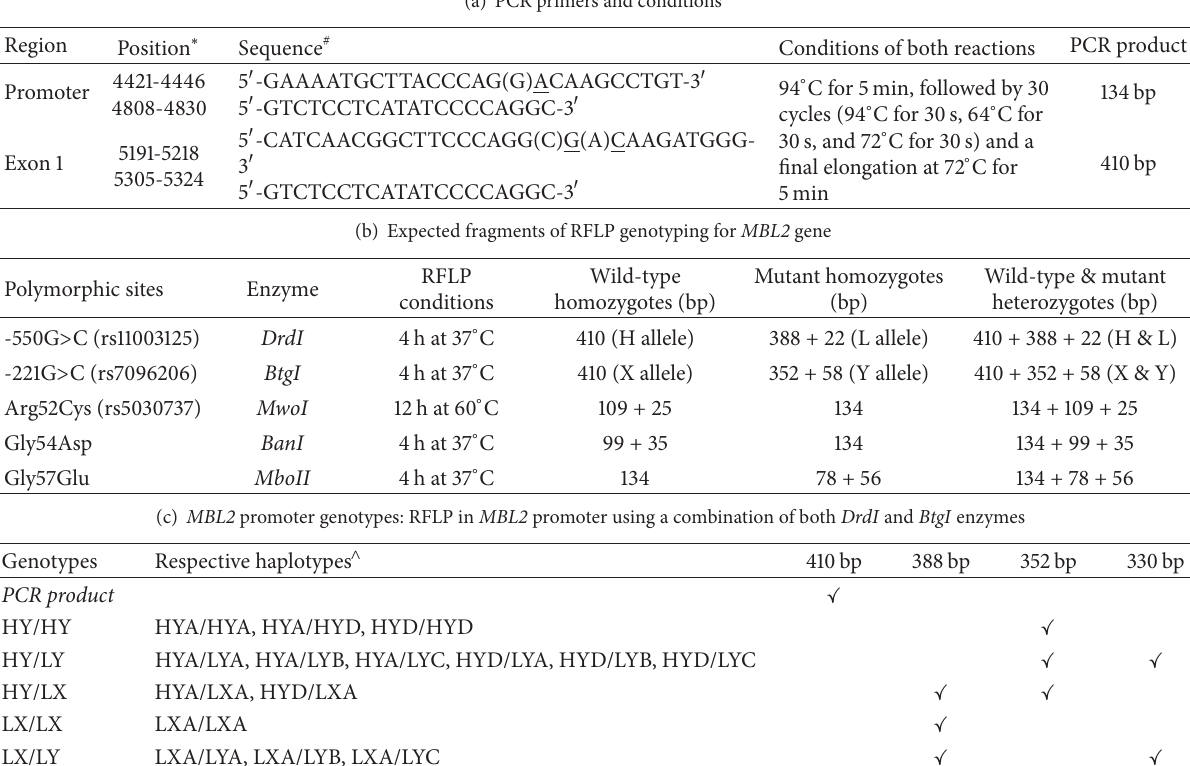
Table 1: PCR-RFLP protocol for the detection of MBL2